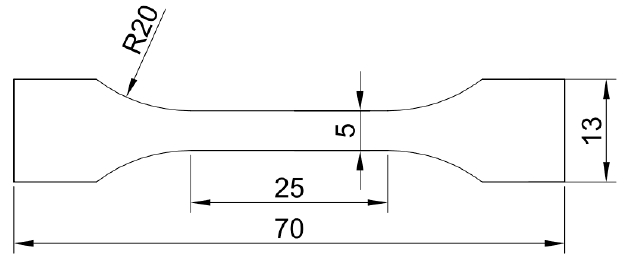
Figure 1. Geometry of samples for a tensile test.